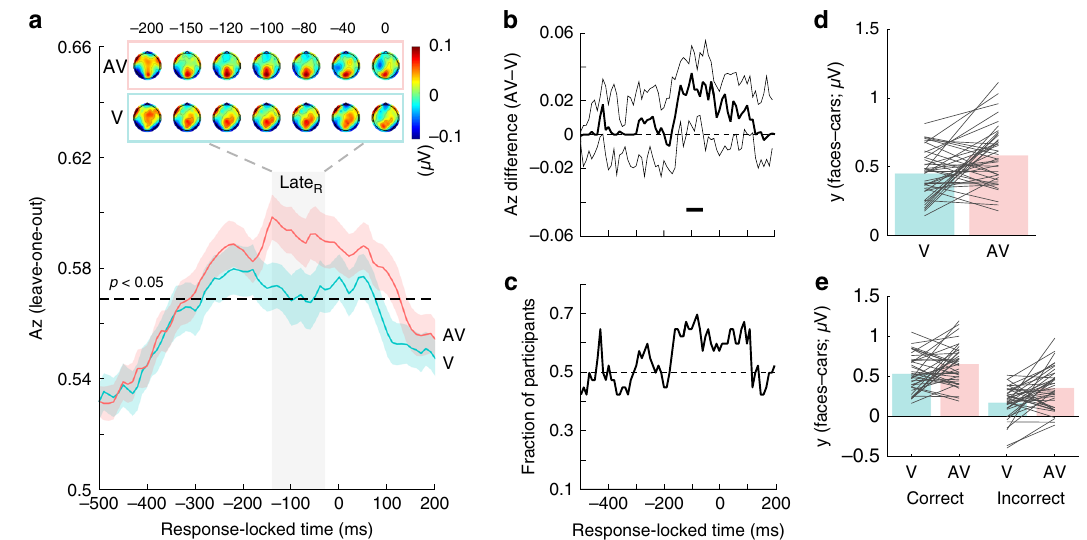
Fig. 4 Response-locked face-vs-car discrimination analysis. a Mean discriminator performance ( A z ) during face-vs-car discrimination of response-locked EEG data after a leave-one-trial-out cross-validation procedure, as a function of the visual (V; turquoise) and audiovisual (AV; red) conditions. Dashed black line represents the group average permutation threshold at p < 0.05. Shaded error bars indicate bootstrapped standard errors (SEM) across participants. Shaded gray vertical bar indicates Late component window used in the selection of component amplitudes ( y ) shown in d . This window resulted from a temporal cluster-based bootstrap analysis performed on median A z difference scores (for details, see description of b and “ Methods ” section). Scalp topographies at representative time windows corresponding to the Late EEG component (indicated by dashed lines) encoding persistent post-sensory visual evidence up until the eventual commitment to choose. Colourbar represents normalized amplitude ( µ V). b Bootstrapped difference in discriminator performance (AV – V; thick black line) with 95% con fi dence intervals (2.5 – 97.5%; thin black lines). Gray shaded area in a and horizontal thick black line above the x -axis in b illustrate signi fi cant temporal windows resulting from this one-sided permutation test (i.e., those in which the lower con fi dence interval is greater than zero ( p < 0.025) with an added data-driven minimum requirement of three contiguous windows to correct for multiple comparisons; see “ Methods ” ). This procedure corrects for multiple comparisons. c Fraction of participants showing discriminator performance ( A z ) in the same direction as the group-level mean. d Late EEG component amplitudes re fl ecting the relative separation across face and car trials ( y faces – y cars ) at the point of maximum A z separation between V and AV trials (see a , b ). e Late EEG component amplitudes ( y ) as in d separated by decision accuracy. Reproducibility was ensured using an out of sample leave-one-trial-out cross-validation procedure per participant, whereby each participant becomes its own replication unit (for details, see “ Methods ” ). Source data for this fi gure are provided as a Source data fi compared to V trials (Fig. 5d; two-sided paired t tests: t (39) = best fi tting model suggests that the effect of task dif fi culty on = − 2.66, p = 0.011 for γ − 0.6891, p = 0.4984 for γ behavioral performance is captured by post-sensory mechanisms. Early , t (39) Late ).